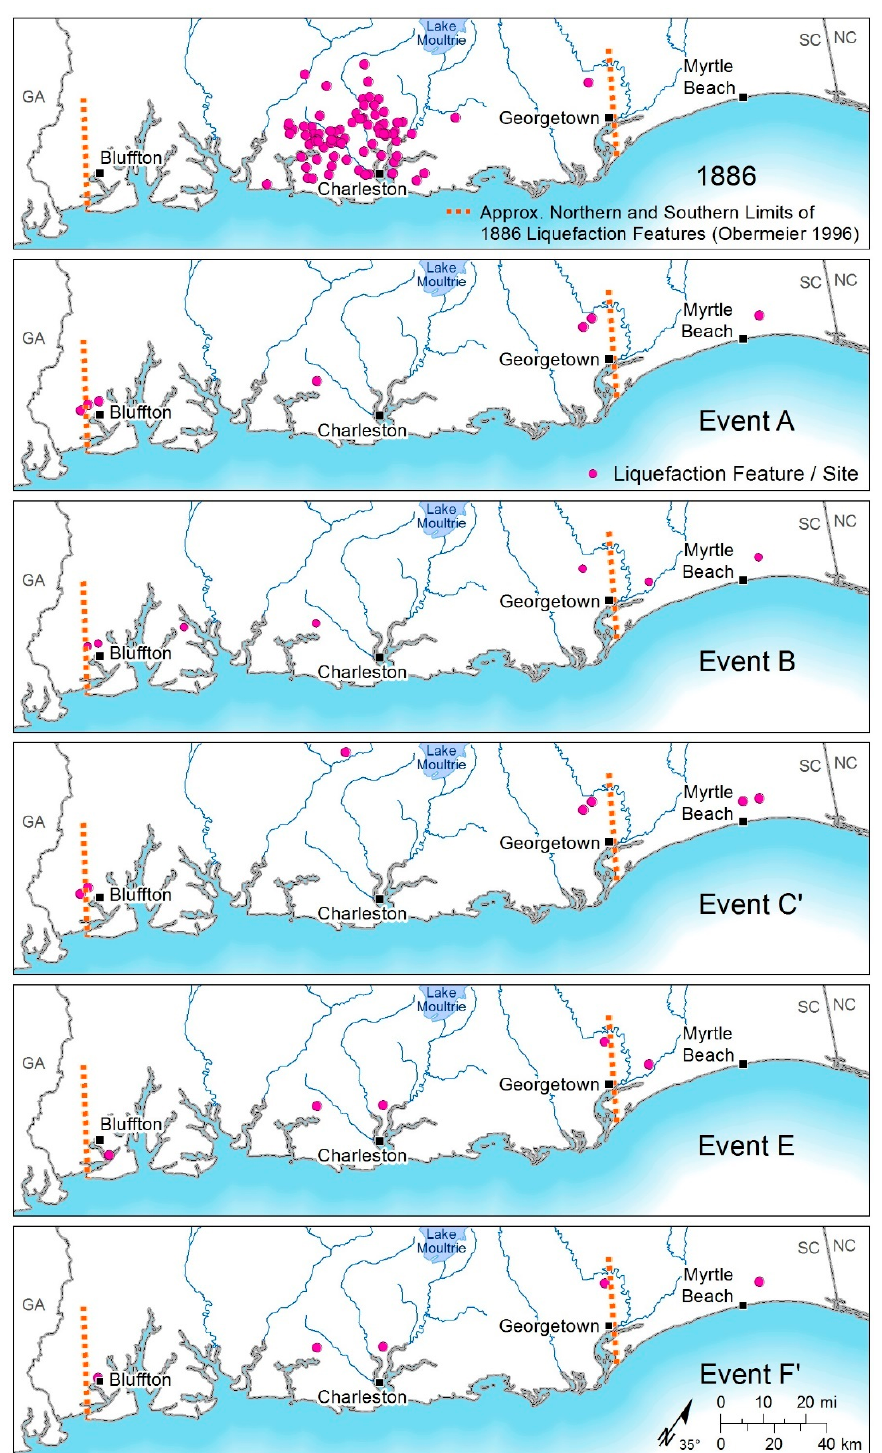
Figure 23. Time series of maps showing the distribution of earthquake-induced liquefaction features in the vicinity of Charleston (South Carolina) and the approximate location of the AD 1886 earthquake. Each panel represents a different earthquake: (top row) AD 1886 and Event A (~546 years BP); (middle row) Events B (~1021 years BP) and C’ (~1683 years BP); (bottom row) Events E (~3548 years BP) and F (~5038 years BP) (modified from References [11,12]). A recurrence time of 500–600 years was estimated from the timing of the past three events (AD 1886 and Events A and B), in which there was more confidence than the earlier three events [12]. Red dashed lines show approximate northern and southern limits of 1886 liquefaction features [100].